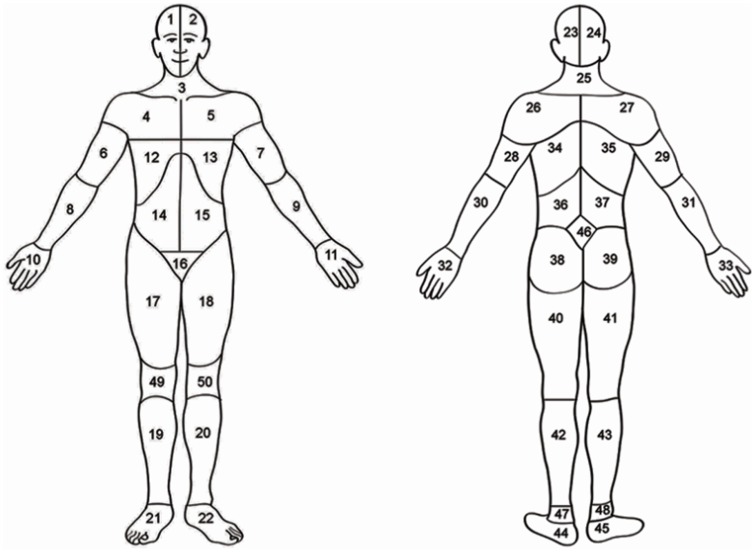
Body map. Head (areas 1, 2, 23, or 24); neck (areas 3 or 25), shoulders (areas 4, 5, 26, 27); arms (areas 6, 7, 8, 9, 28, 29, 30, or 31); hand (areas 10, 11, 32, 33); ribs or chest (areas 12 or 13); abdomen (areas 14 or 15), back (areas 34, 35, 36, 37), buttocks or hips (areas 38 or 39); genitalia (area 16), legs (areas 17, 18, 19, 20, 40, 41, 42, or 43); feet (areas 21, 22, 44, or 45). Adapted from Margolis et al. (1986).